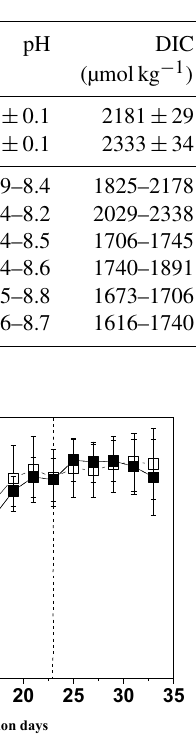
Table 1. Dissolved inorganic carbon (DIC), pH, p CO 2 and nutrient concentrations in the mesocosm experiments. “–” means that the values were below the detection limit.